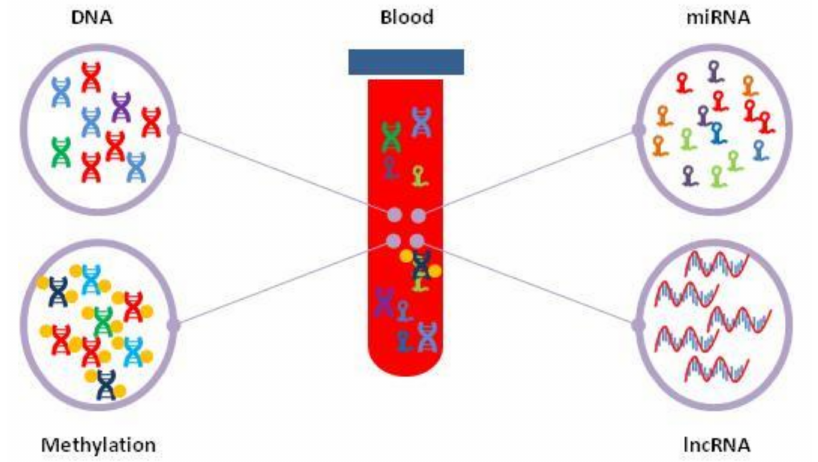
Figure 1. Schematic representation of the liquid biopsy as tool for the analysis of circulating DNAs and RNAs released from apoptotic or necrotic cancer cells into the blood